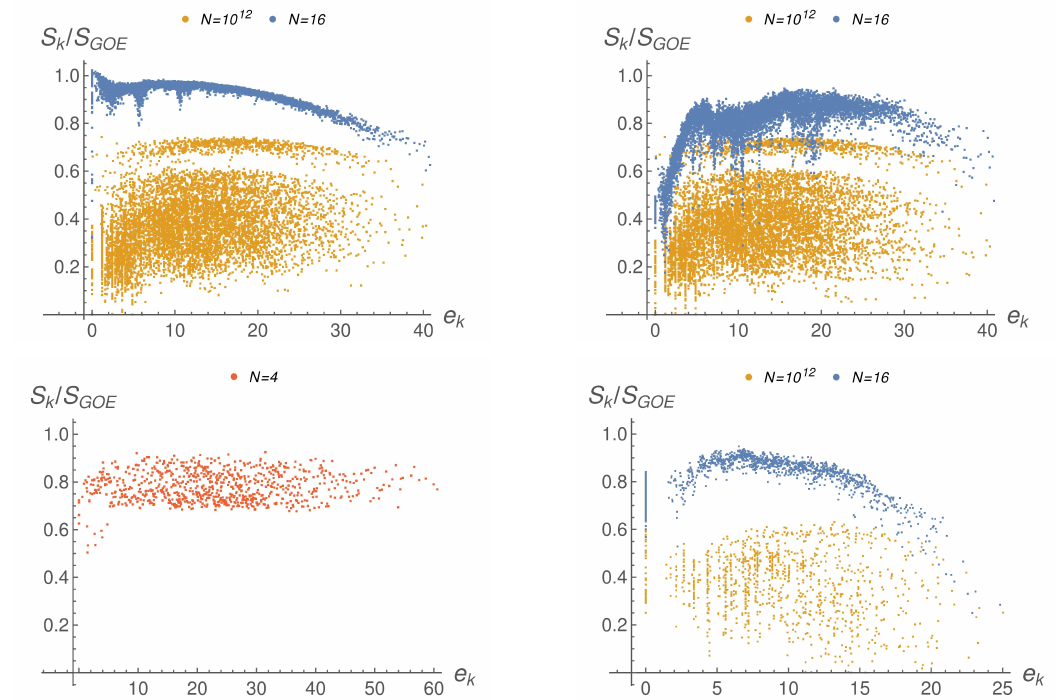
Figure 8: Information entropy of eigenvectors from the L = 16, M = 7 sector of the β -deformed theory at N = 10 12 (top left, yellow, m = 8512), N = 16 (top left, blue, m = 8512) and N = 4 (bottom left, m = 846). On the top right we consider the same quantities but for the transpose of the mixing matrix. The information entropy of the two-loop dilatation operator of the undeformed theory in the positive-parity sector is plotted for both N = 10 12 (bottom right, yellow, m = 1201) and N = 16 (bottom right, blue, m =